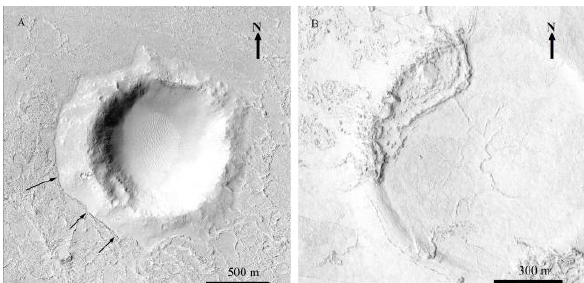
Figure 6. Observations of PRP terrains in Elysium Planitia. (A) The PRP terrain lapped against one crater rim with a thick frontier as shown by the arrows; subset of HiRISE image ESP_018049_1885_RED.jp2. (B) The flow crossed over the crater rim seen in its interior; subset of HiRISE image PSP_006472_1855_RED.jp2.